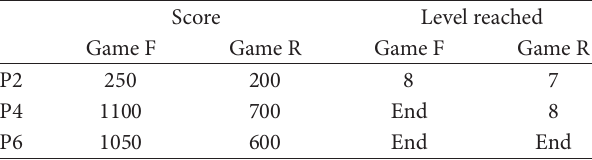
Table 3: Player scoring and game completion data for Group